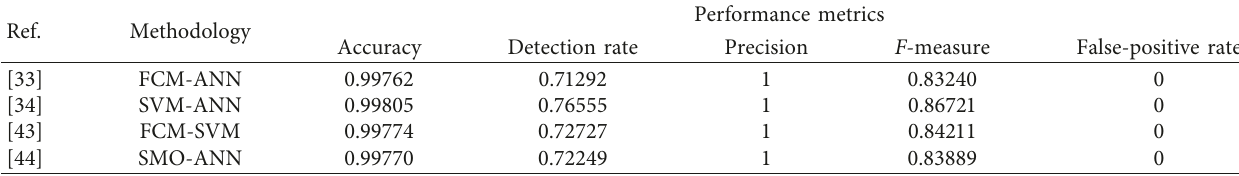
Table 16: Comparison of various methodologies based on different performance metrics for root-to-local (R2L) attack. Ref.